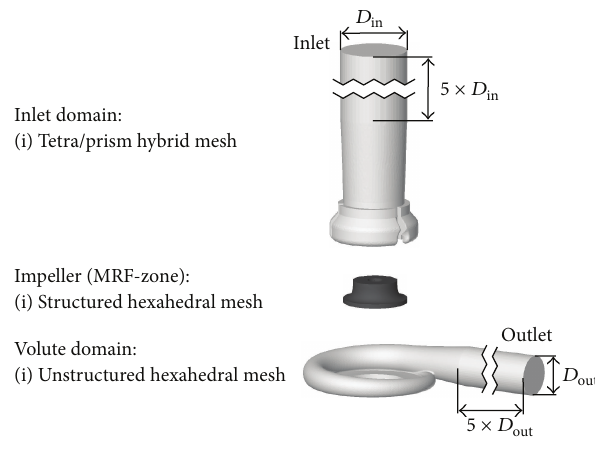
Figure 8: Computational domain of the compressor. Table 2: Cell count for the grid dependency study and average nondimensional wall distance 𝑦 + for the near-wall